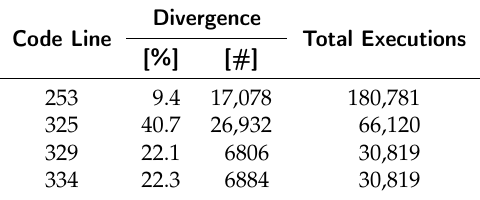
Table 3. Extract from the profiling analysis executed by Nsight. The analysis shows the most divergent instructions in our CUDA main code